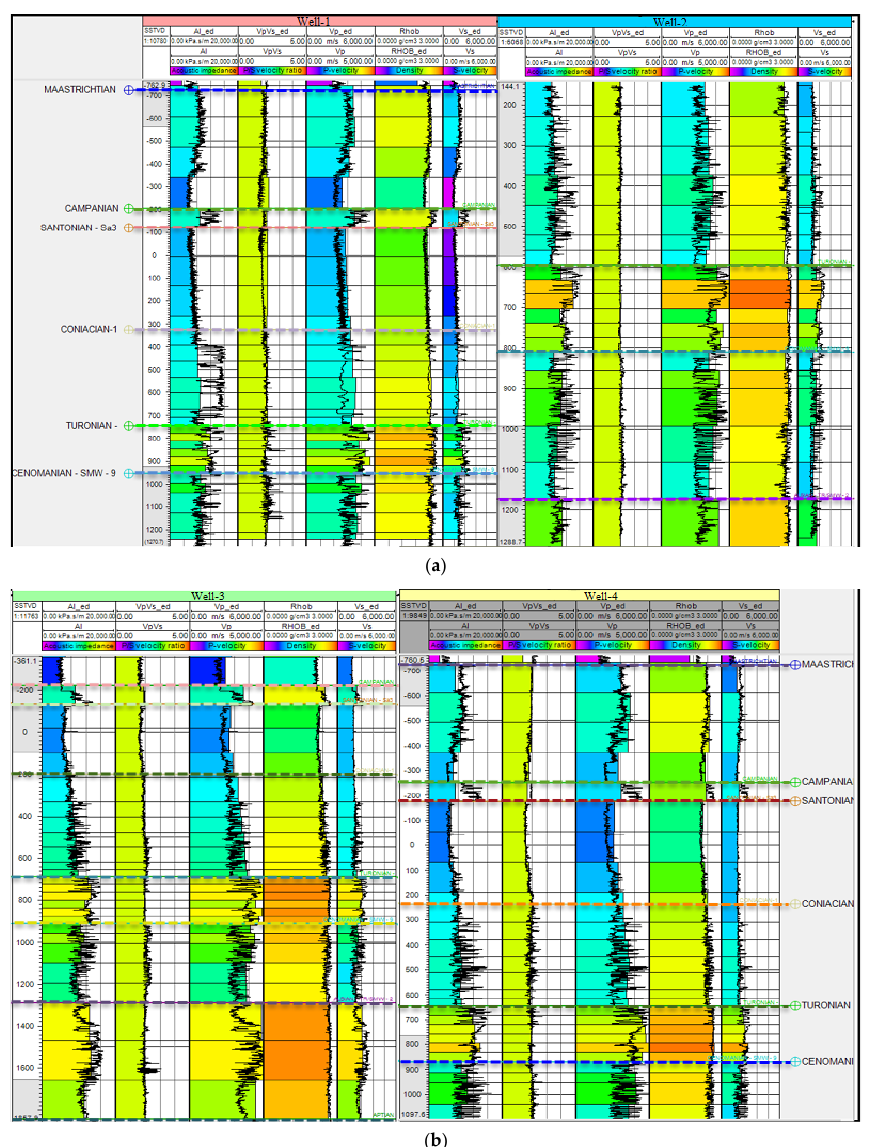
Figure 5. Volumes generated using seismic inversion: ( a ) acoustic velocities (m/s), ( b ) shear rates, ( c ) density AI (k.Pa.s/m).